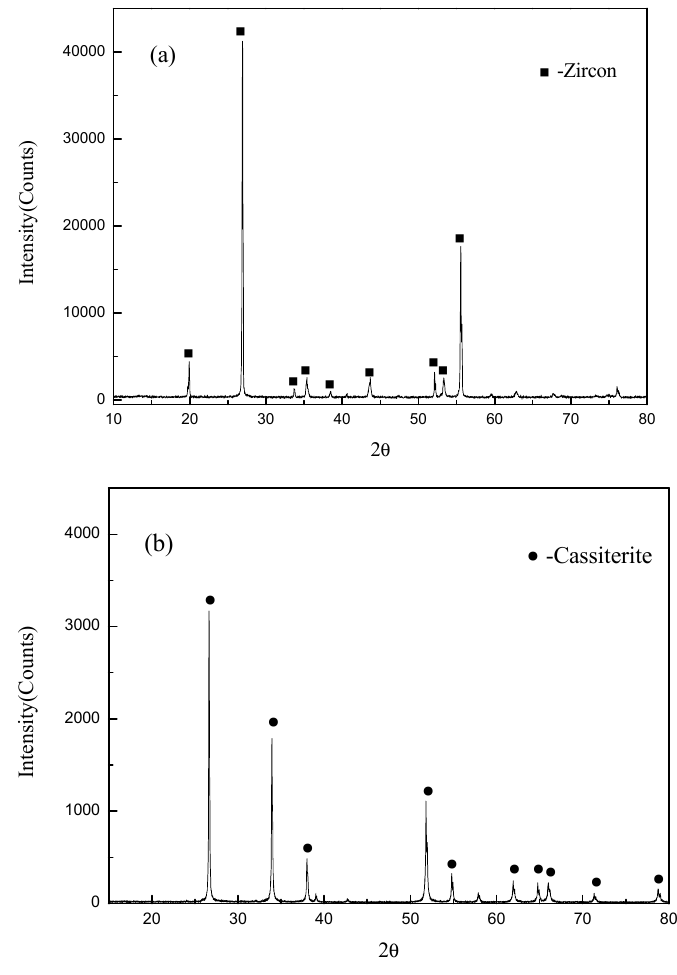
Figure 1. X-Ray diffraction (XRD) patterns of zircon ( a ) and cassiterite ( b ). Table 1. Chemical compositions of the purified samples (mass fraction, %).